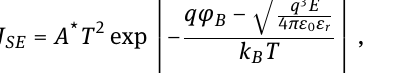
tical dielectric constant decrease with increasing tempera-